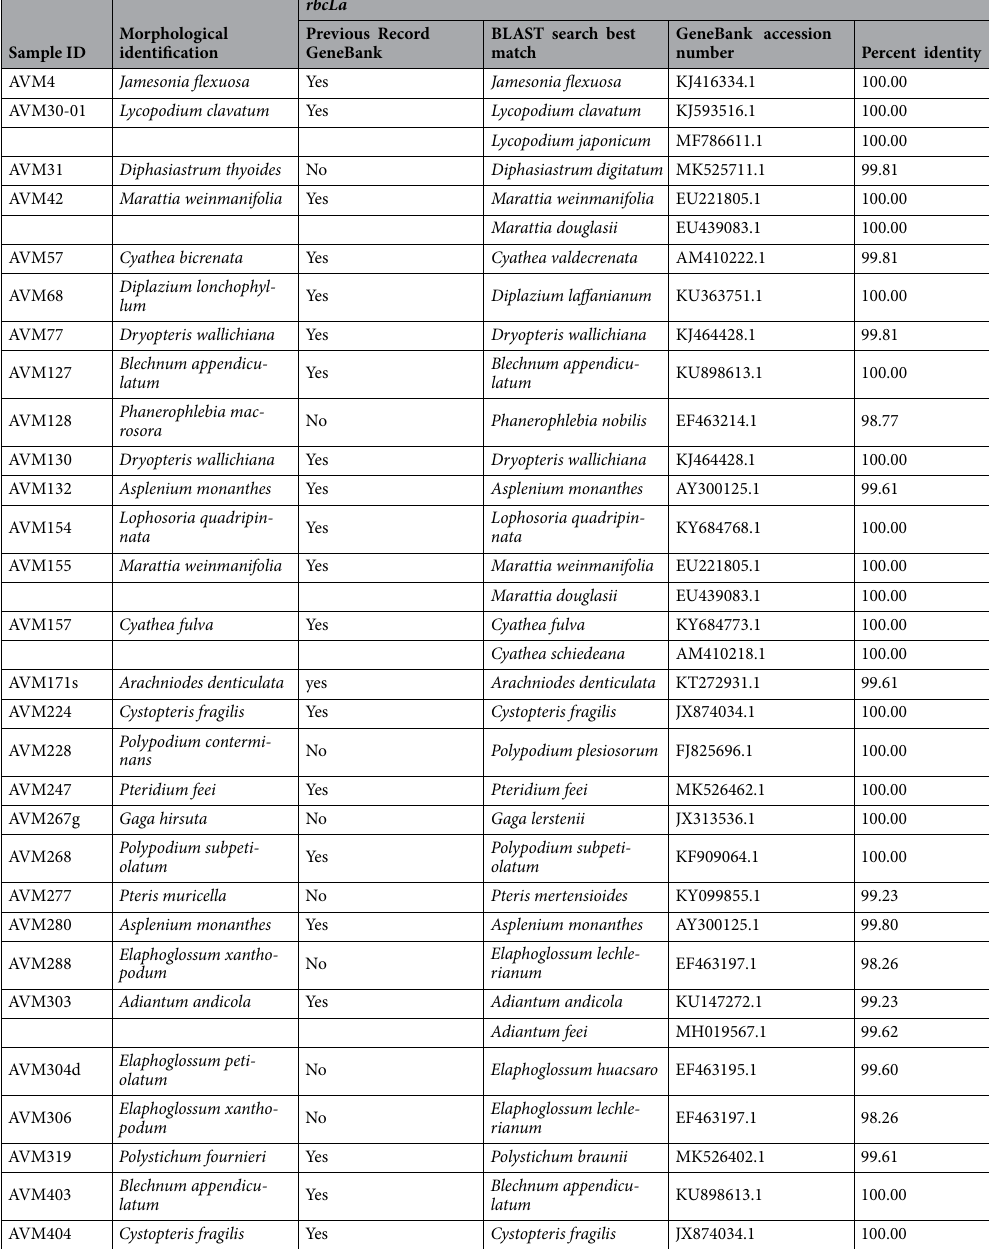
Table 4. BLAST search best match found on GeneBank for ferns and allies of the Mixteca Alta, Oaxaca, Mexico, using DNA sequences obtained from the partial gene rbcLa